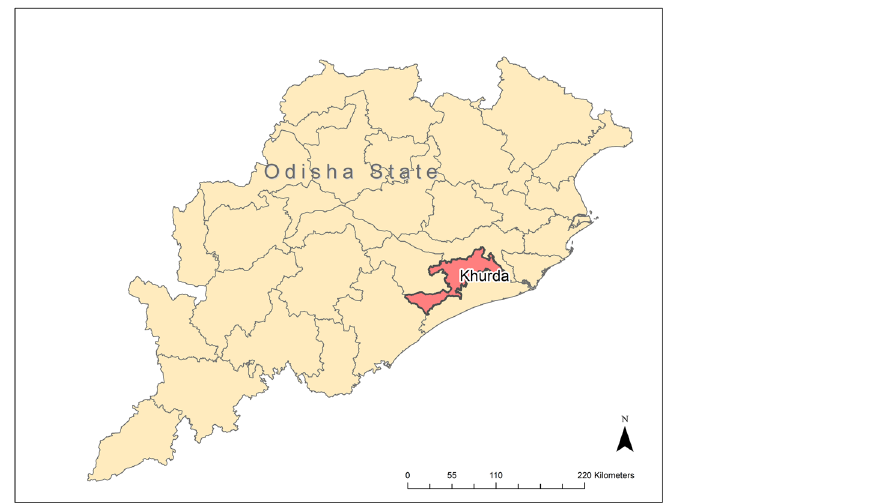
Fig 2. Khurda District, Odisha State, India. (Map generated in ArcGIS